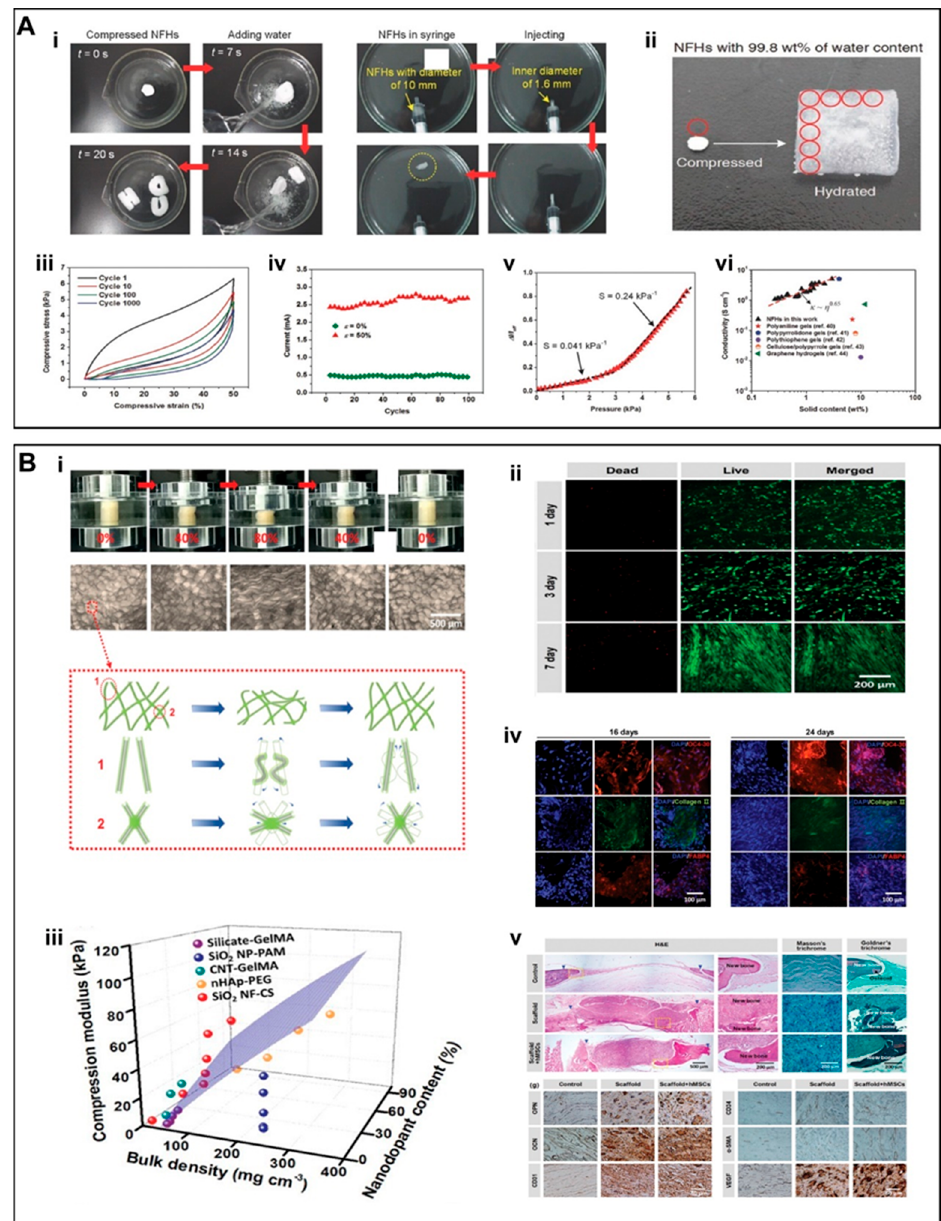
Figure 3. A (i) Stent shape recoverability and injectability. (ii) NFH with an ultra-high water content of 99.8 wt.%. (iii) A fatigue compression test with 1000 cycles and at ε = 50%. (iv) 100 cycle current compression-responsive test at ε = 50%. (v) Response of NFHs toward applied current at various pressures. The dotted lines showed two linear regions with different sensitivities. (vi) Electrical conductivities of NFHs and other selected hydrogels with high water content. B (i) Macroscopic and microscopic structural changes during compression and shape recovery in aqueous medium. (ii) Live/dead staining of hMSCs. (iii) 3D compression modulus map of SiO 2 NF-CS scaffolds as compared to other nanodopants-enhanced hydrogels reported in literatures. (iv) Representative images for the immunostaining of OC4-30 (red), collagen II (green), and FABP4 (red). (v) Histological staining by using H&E, Masson’s trichrome, and Goldner’s trichrome as well as immunostaining by using OPN, OCN, CD31, CD34, α -SMA, and VEGF of rat cranial defects at 10 weeks postoperatively. A(i–vi) Reproduced with permission from Ref. [82]. Copyright 2017 WILEY-VCH Verlag GmbH & Co. KGaA, Weinheim. B(i–v) Reproduced with permission from Ref. [84]. Copyright 2019 WILEY-VCH Verlag GmbH & Co. KGaA, Weinheim. Similarly, Wang et al. [86] developed flexible binary SiO 2 -CaO nanofiber mem- branes to afford 3D SiO 2 -CaO NF/CS scaffolds (Figure 4B i). The 3D SiO 2 -CaO NF/CS